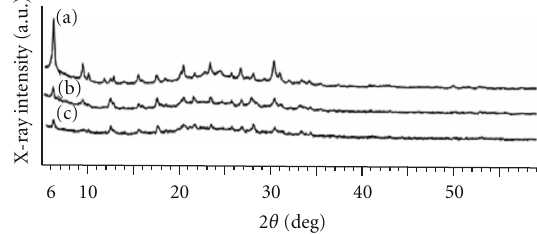
Figure 2: XRD patterns of (a) the NCY, (b) Fe-NCY, and (c) Fe- OP-NCY